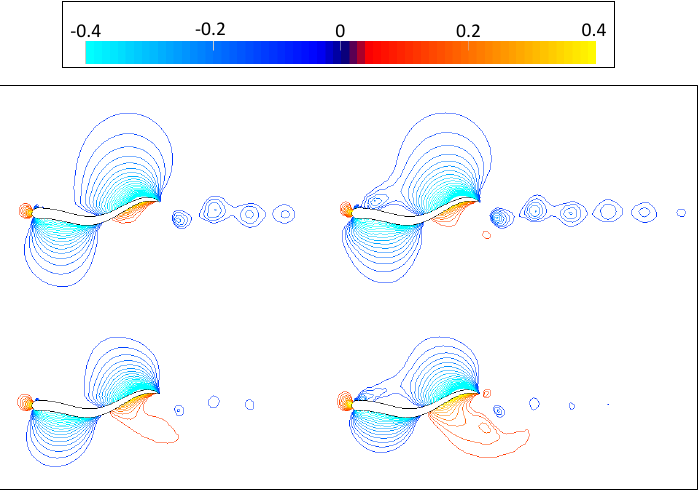
Figure 19. The wake of the rectangle swarm at the spacing of 1.5 L .